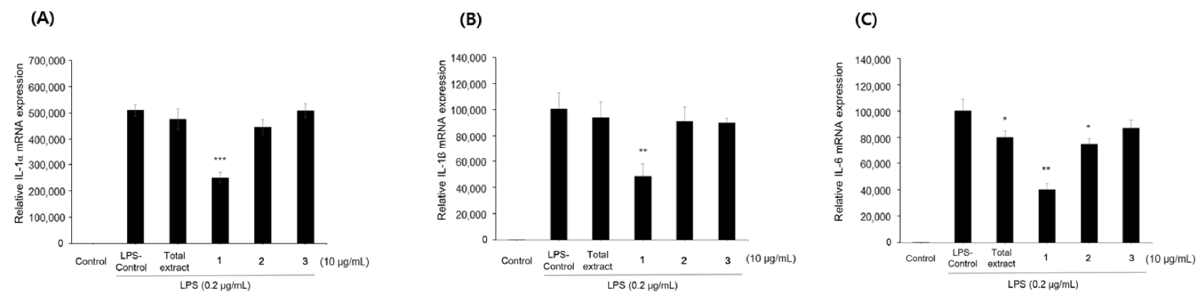
Figure 3. Effects of L. lucidum fruits extract and compounds 1 – 3 on the mRNA expression of cytokines, ( A ) IL-1 α , ( B ) IL-1 β and ( C ) IL-6, in LPS-stimulated RAW264.7 macrophages. All data are presented as the mean ± SEM ( n = 3). Quercetin (Q5, 5 µ g/mL) was used as the positive control. * p < 0.05, ** p < 0.01 and *** p < 0.001 indicate significant differences compared to the LPS control group.